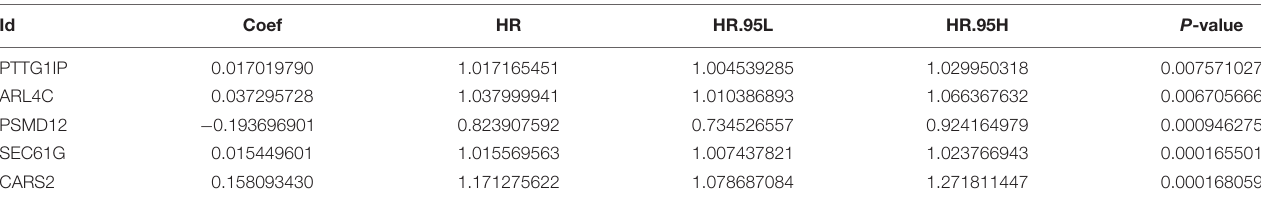
FIGURE 4 | Establishing a hypoxia prognostic model by LASSO regression analysis. (A) LASSO coefficient plot of 18 candidate survival-related genes in the training group. The hypoxia genes with non-zero coefficient are identified through the optimal Log Lambda value for the subsequent model construction. (B) The best Log Lambda value (corresponding to the minimum cross validation error point) is selected for the training group in the LASSO model, with a vertical dotted line drawn here. (C) The forest map visually shows HR values and 95% confidence intervals for all model genes. HR < 1 indicates that this gene is a low-risk gene; otherwise, it is a high-risk gene. P < 0.05 indicates that this gene is an independent prognostic factor. TABLE 2 | Multivariate COX regression analysis results of model